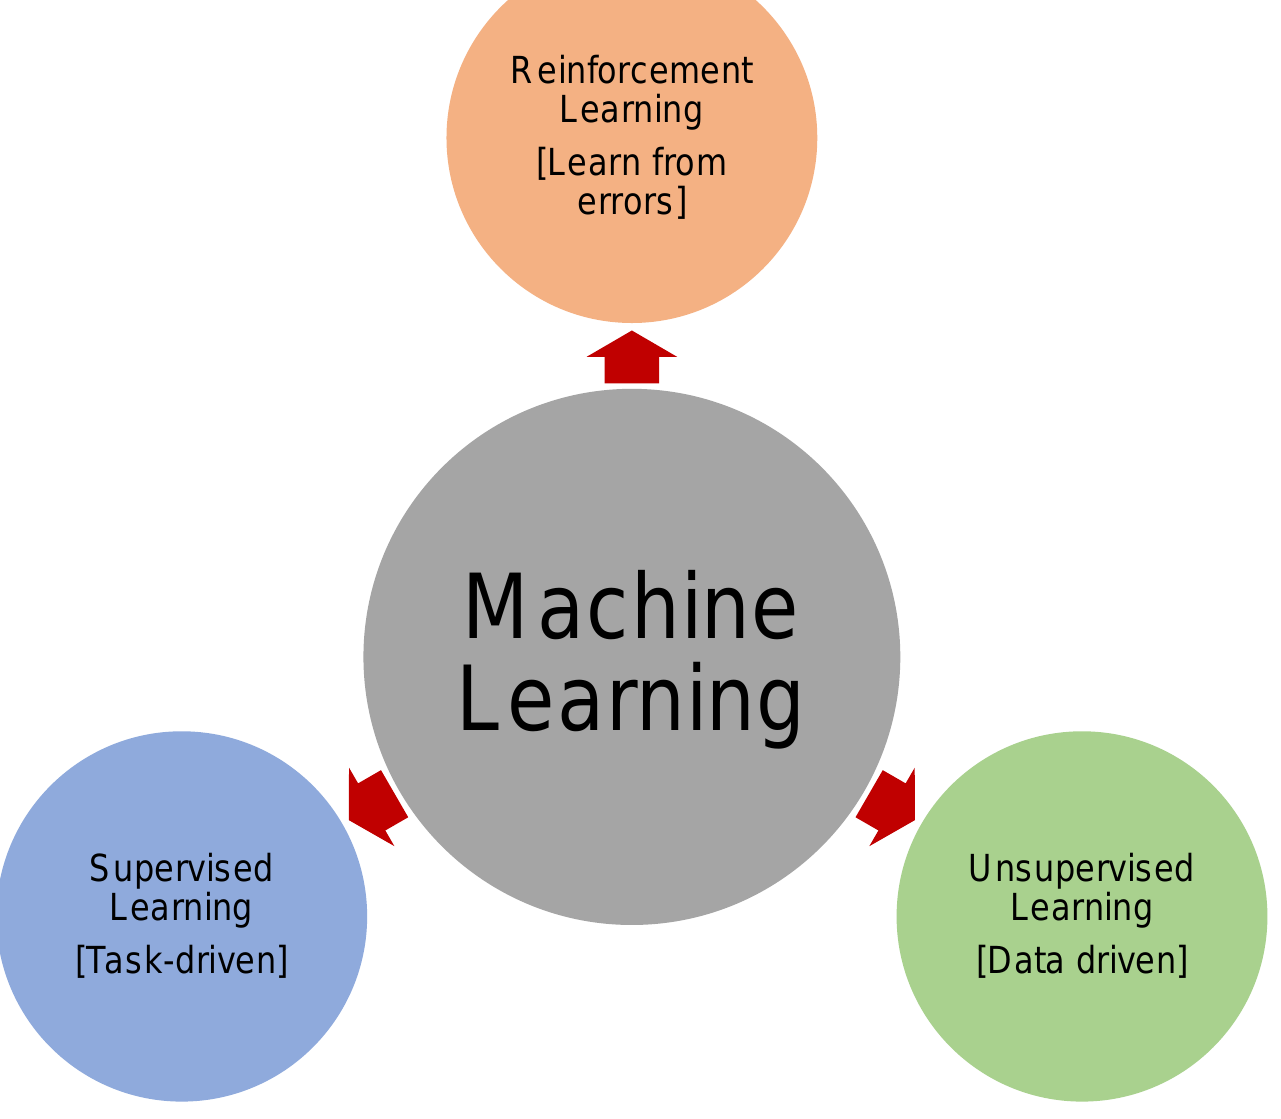
Figure 1. Categories of machine learning.